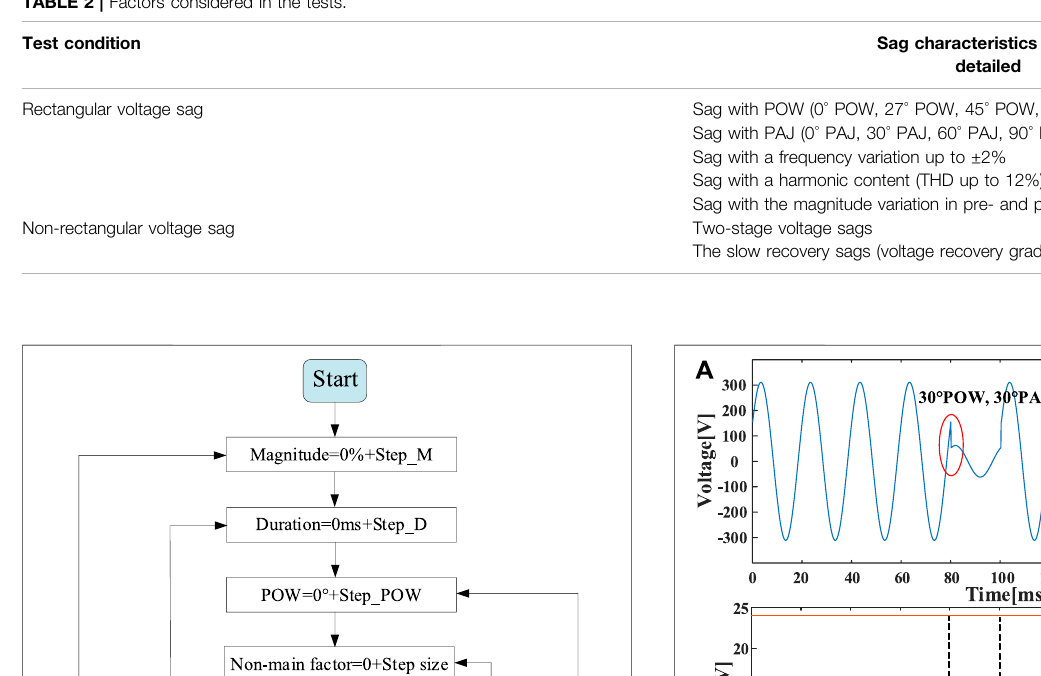
TABLE 2 | Factors considered in the tests.